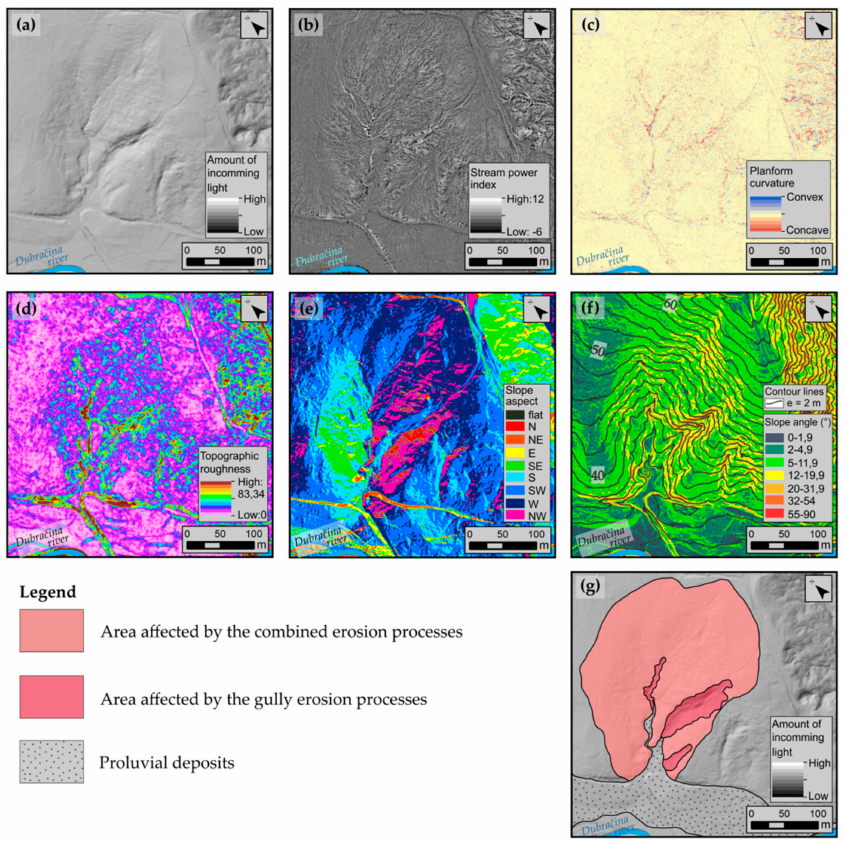
Figure 9. Visualization of topography of area a ff ected by the combined erosion processes on HR LiDAR imagery: ( a ) the semi-transparent (50%) hillshade map 45 ◦ / 45 ◦ over the hillshade map 315 ◦ / 45 ◦ ; ( b ) the stream power index map; ( c ) the planform curvature map; ( d ) the topographic roughness map; ( e ) the aspect map; ( f ) the contour line map over the slope map. ( g ) The hillshade map with delineated polygons representing the area a ff ected by the combined erosion processes, the area a ff ected by the gully erosion processes, and the proluvial